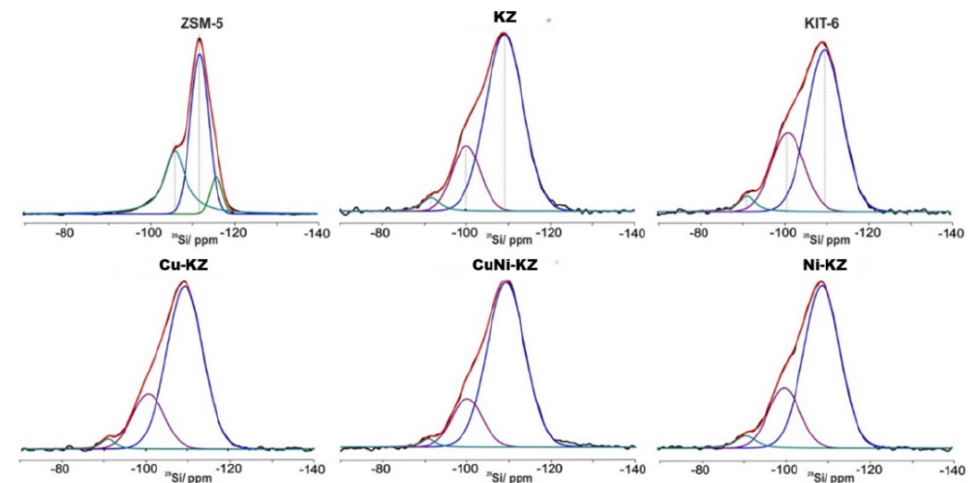
Figure 4. Experimental (black) and simulated (red) single-pulse 29 Si NMR spectra of the studied zeolites. The individual contributions of the different Si environments are given with colored lines: green-Si(2OH) 91 ppm; pink-Si(1Al) + Si(OH) 100 ppm; blue-Si(0Al) –109 ppm).